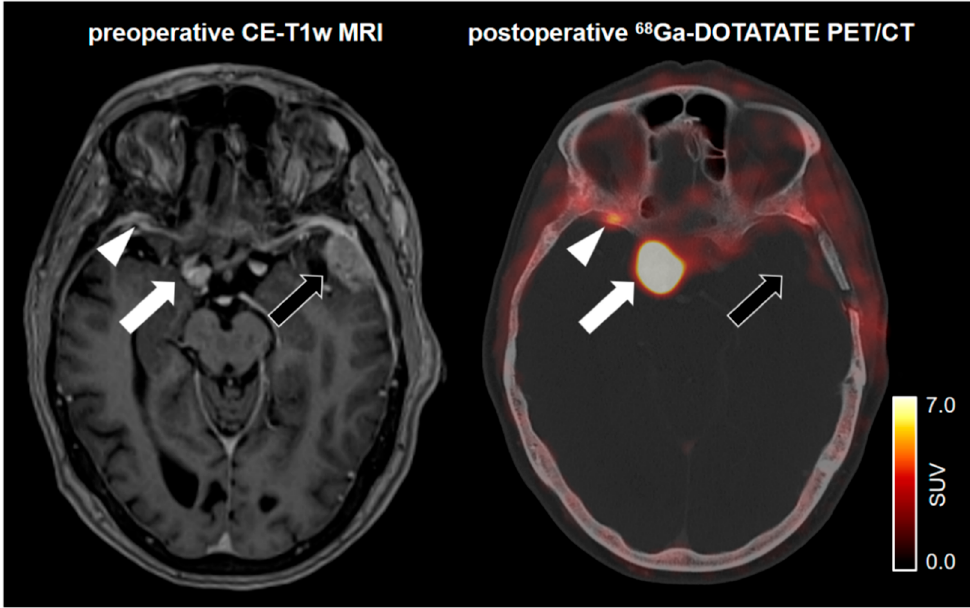
Figure 2. 75-year-old female patient with a left frontotemporal transitional meningioma of the WHO grade 1. 68 Ga-DOTATATE PET/CT shows no postoperative remnants of the left frontotemporal tumor (black arrow). Pronounced tracer uptake in the right parasellar region indicates a meningioma in correlation to the MRI (white arrow). Notably, a small focal uptake posterior to the right orbital region indicates an additional meningioma. In spatial correspondence, the MRI shows equivocal findings (white arrowhead). SUV = standardized uptake value.